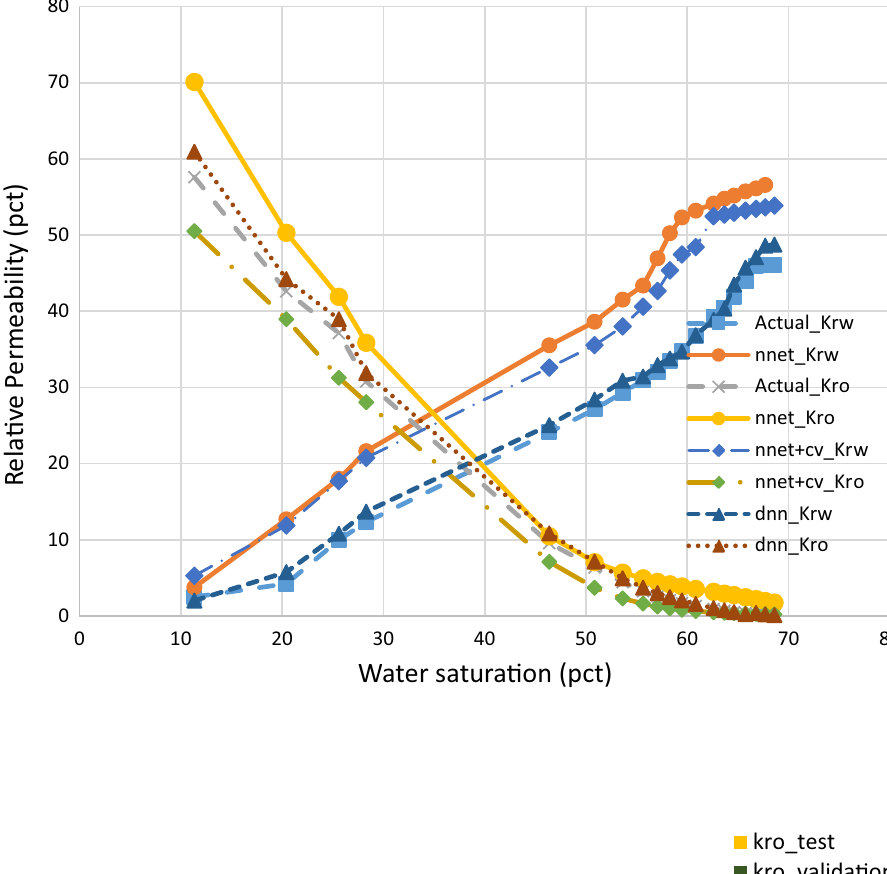
Fig. 9 Comparison of Wyllie, Corey, Parker, Stone, Baker, Honarpour, deep neural net- works for the Brent reservoir, North Sea. The DNN gave bet- ter prediction than the existing models for this validation set. Corey’s , 𝜆 , taken to be 2 and n Parker’s